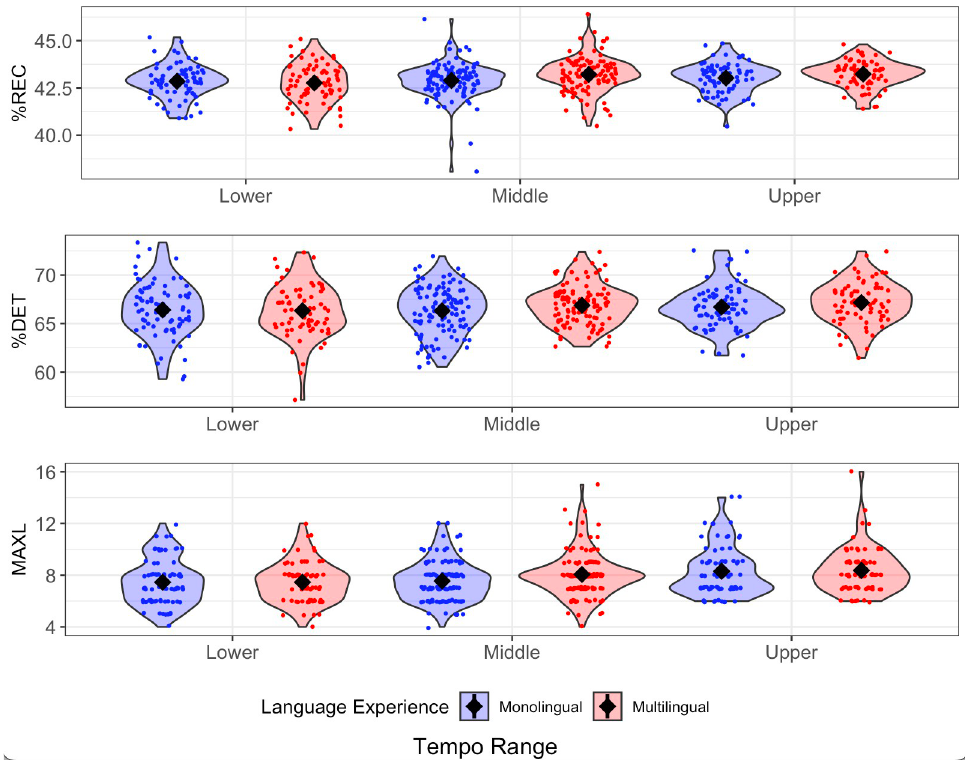
Fig 3. Effects of language experience (red: Multilingual; blue, monolingual) and tempo range on MdRQA metrics: % REC (Panel A, top), %DET (Panel B, middle), and MAXL (Panel C, bottom). The metronome ranged from 80–140 bpm. In our linear mixed effects model, we binned tempo into the following categories: lower (80–90 bpm), middle (100– 120 bpm), and upper (130–140 bpm). The violin plots depict the probability density of the binned tempo data at different %REC, %DET, and MAXL values. The mean value is indicated by a diamond near the center of each violin. Results of statistical analyses are located in Table 2.